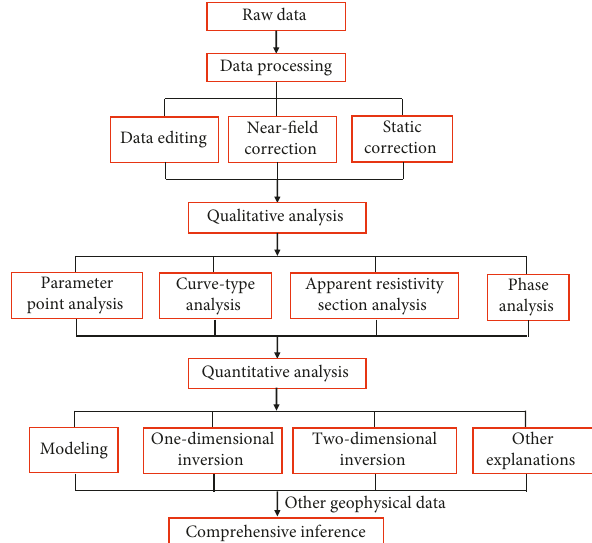
Figure 10: Data processing flow chart of the CSAMT method.